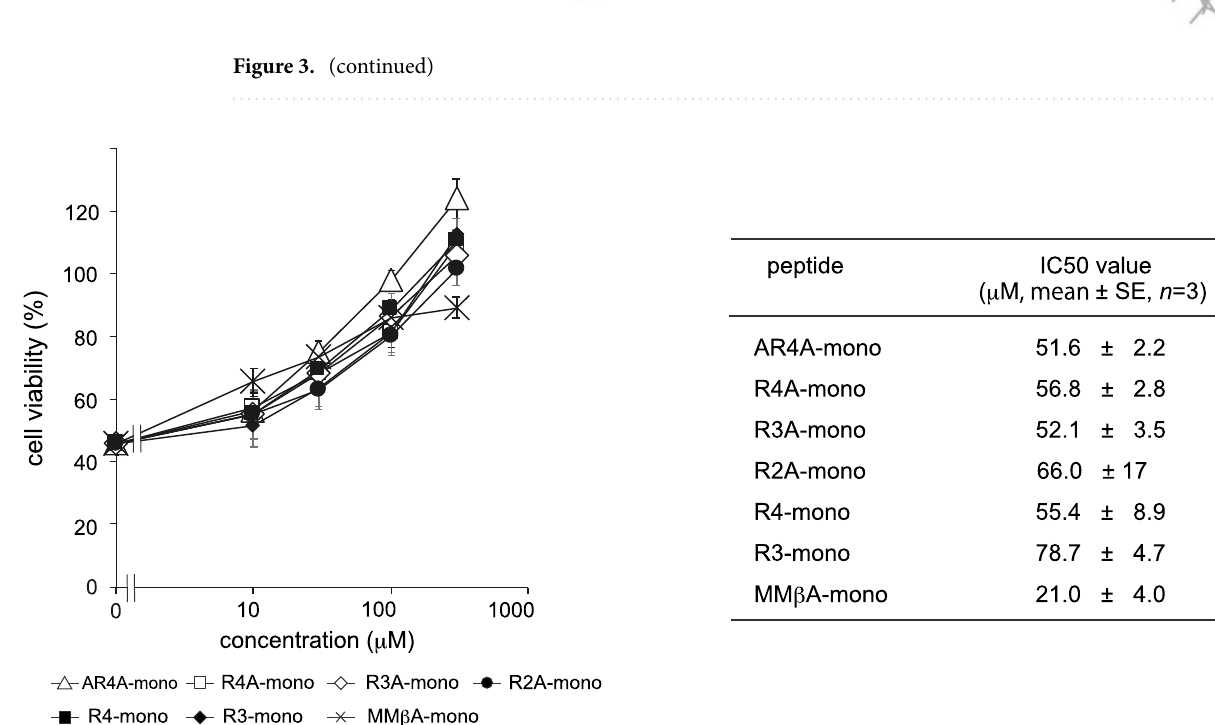
Figure 4. Shorter MMβA-mono-derived peptides efficiently inhibit cytotoxicity of Stx2a. Vero cells were treated with Stx2a for 72 h in the presence of each peptide, and cell viability was measured (left panel). Data are shown as percentage of the control value (mean ± SE, n = 3–7). Peptide IC50 values (i.e., the concentrations that restore viability to 50% of the cells killed with no peptide added) are shown at